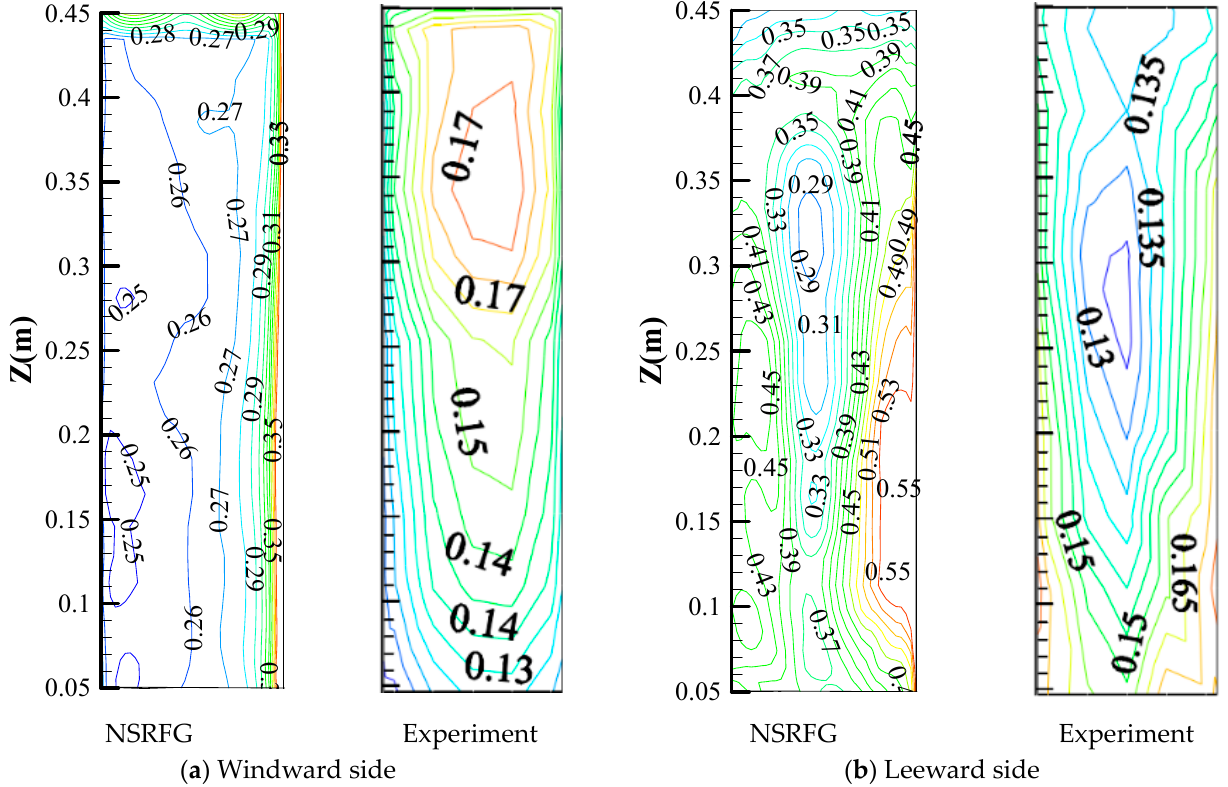
Figure 17. Contours of the fluctuating wind pressure coefficients on the windward and leeward sides.